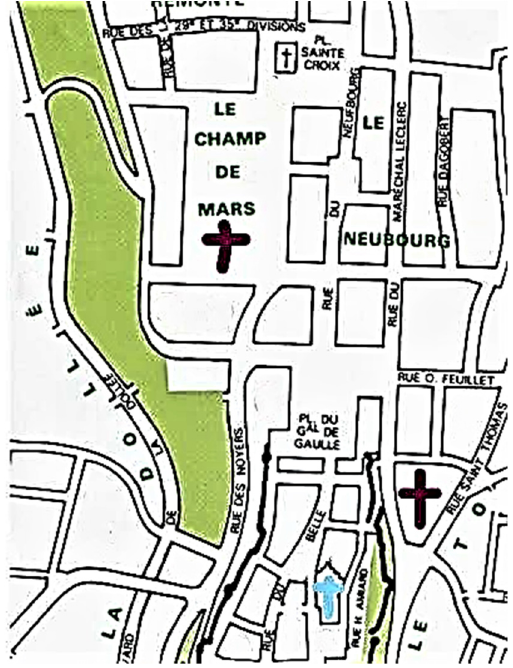
Figure 2. Map of Saint-Lô with red crosses showing the former locations of churches dedicated to Saint-Thomas on the Champ de Mars and the rue Saint Thomas and a blue cross indicating the location of Notre-Dame de Saint-Lô. © adapted by author from Plum (1994).